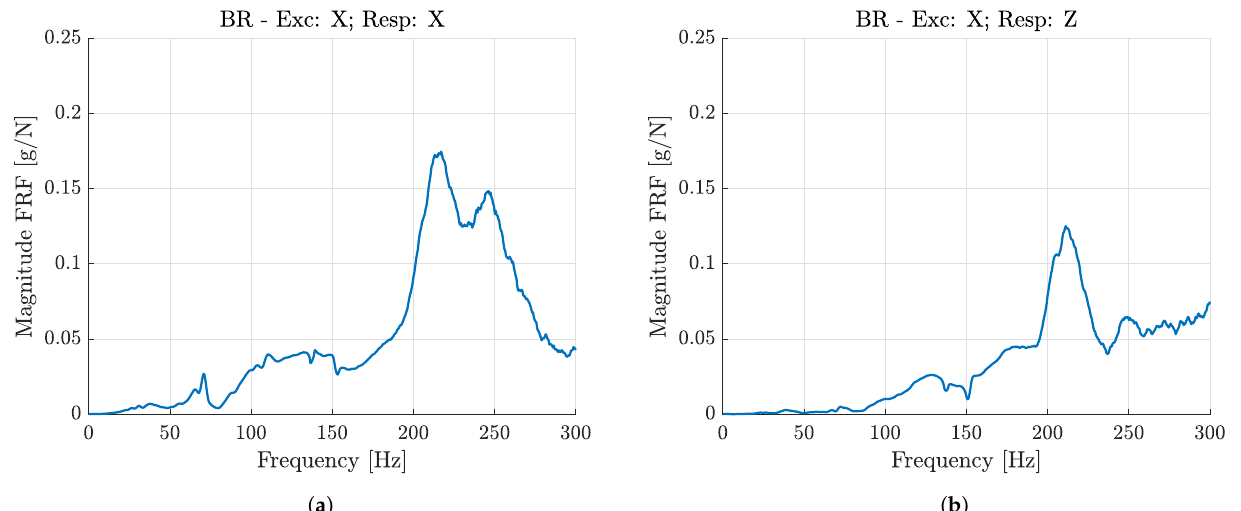
Figure 12. FRFs with the cutting head in the back-right (BR) position. Response in ( a ) X direction and ( b ) Z direction.